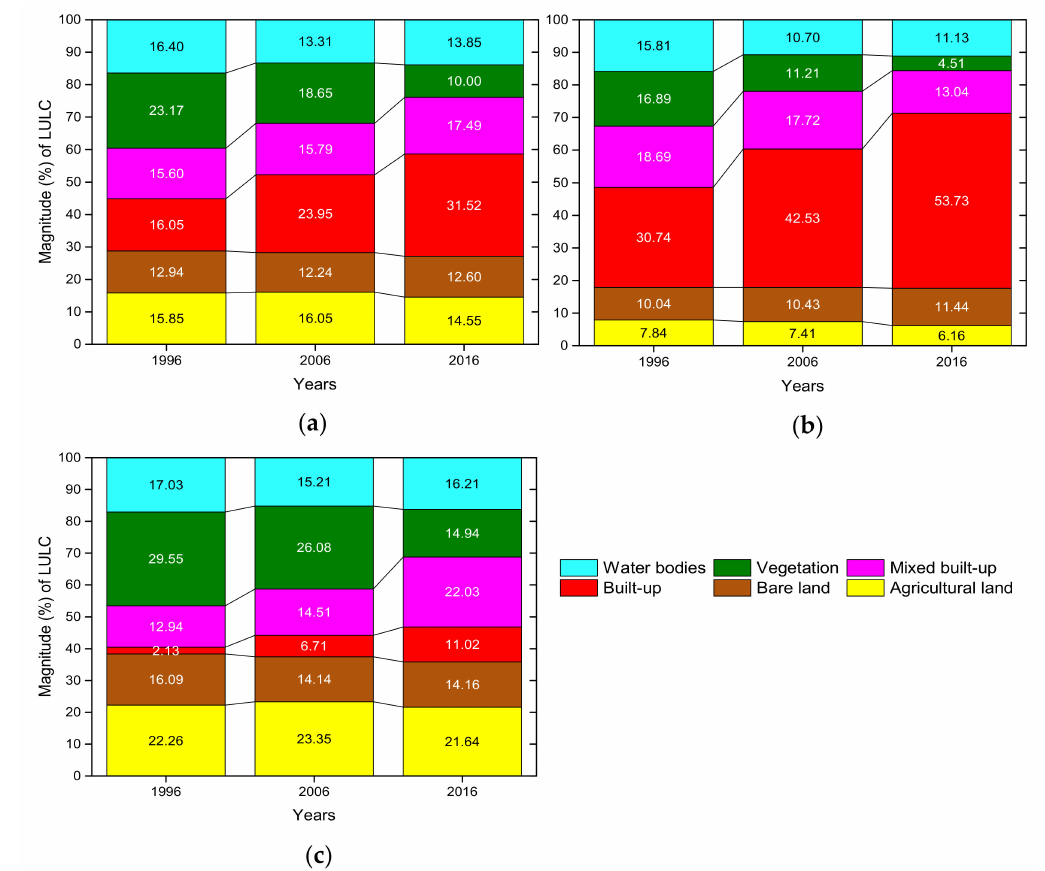
Figure 4. Distribution of percentage of landscape, PLAND (%) of the six LULCs and their temporal change in 1996, 2006, and 2016 in ( a ) KMA, ( b ) KMA-urban, and ( c )